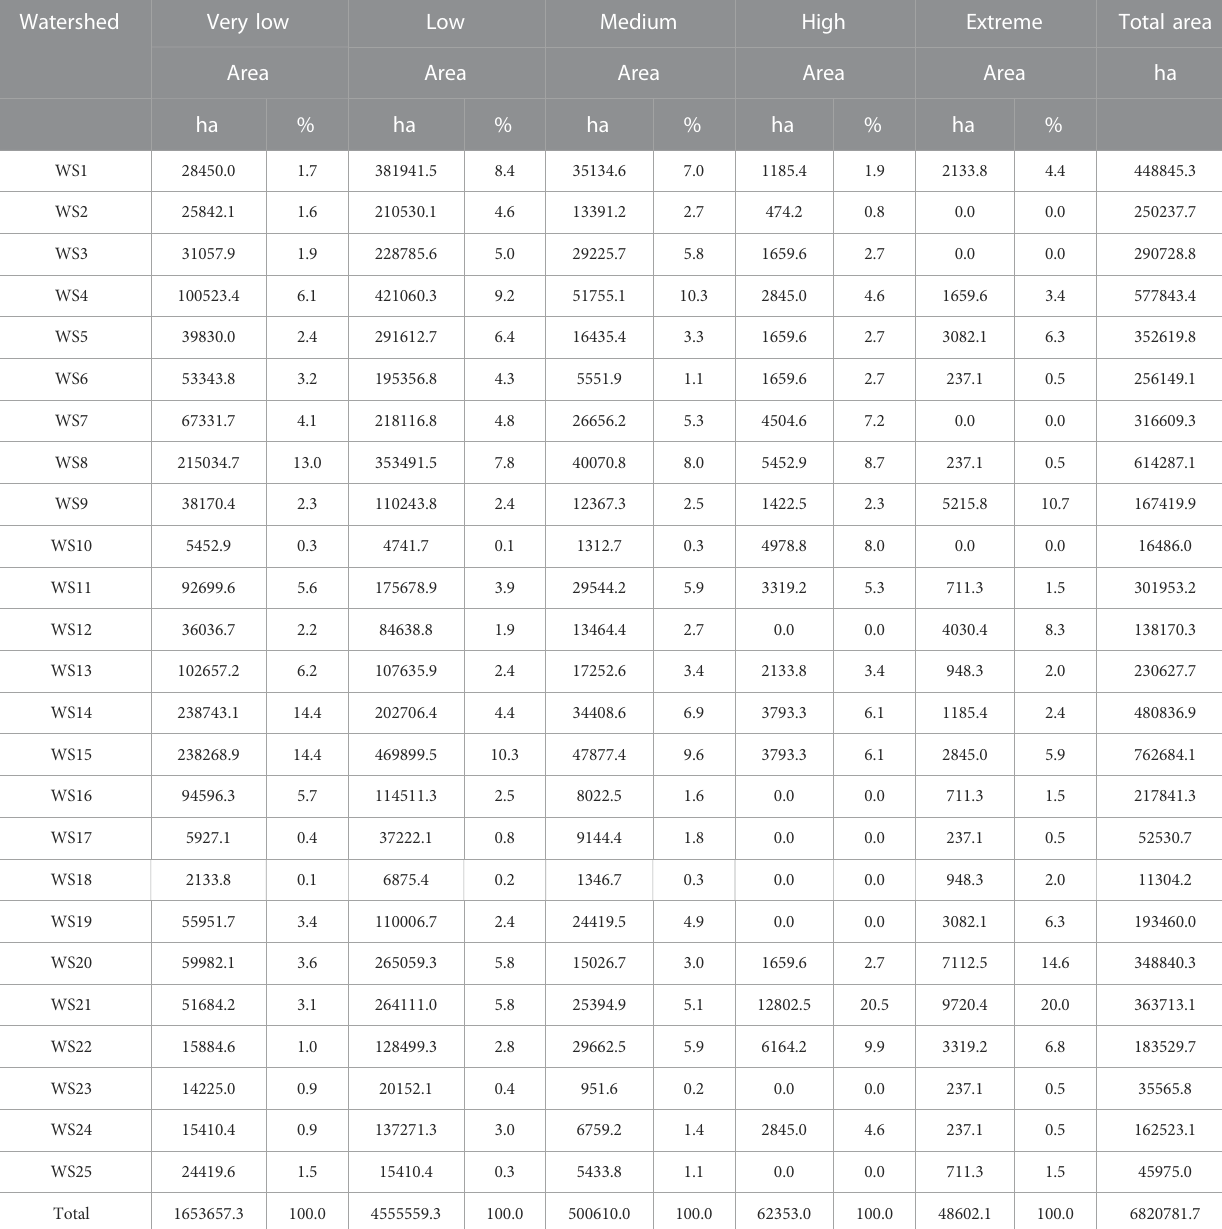
TABLE 4 The area under different severity classes (very low, low, medium, high, and extreme) of soil loss. Watershed Very